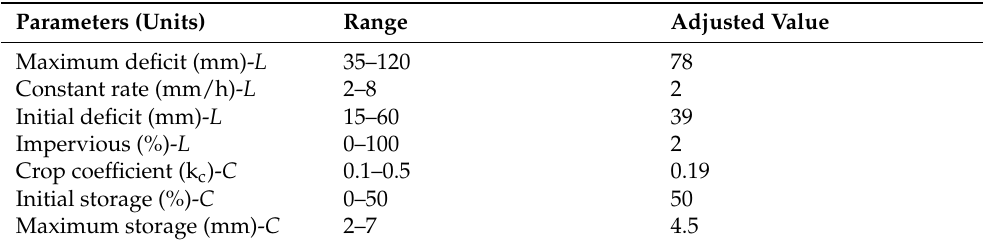
Table 3. HEC-HMS continuous simulation model parameters and their variation